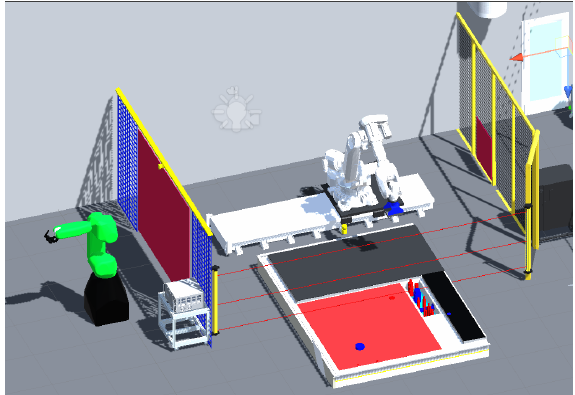
Figure 8. View of Unity 3D scene for safety